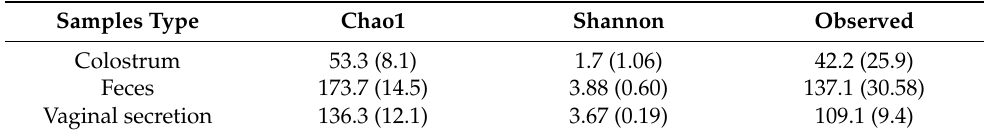
Table 1. Species richness is represented based on an analysis using the Chao1 score, the generation of Shannon diversity values and the qualitative observed index for samples collected from the 20 Holstein cows immediately after calving. The data are presented as the means and standard deviations of the values from all 20 cows by tissue.